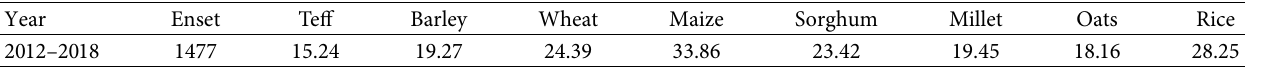
Table 1: Comparison of Enset yield quintal per hectare nexus with common stable crops for 2012–2018.